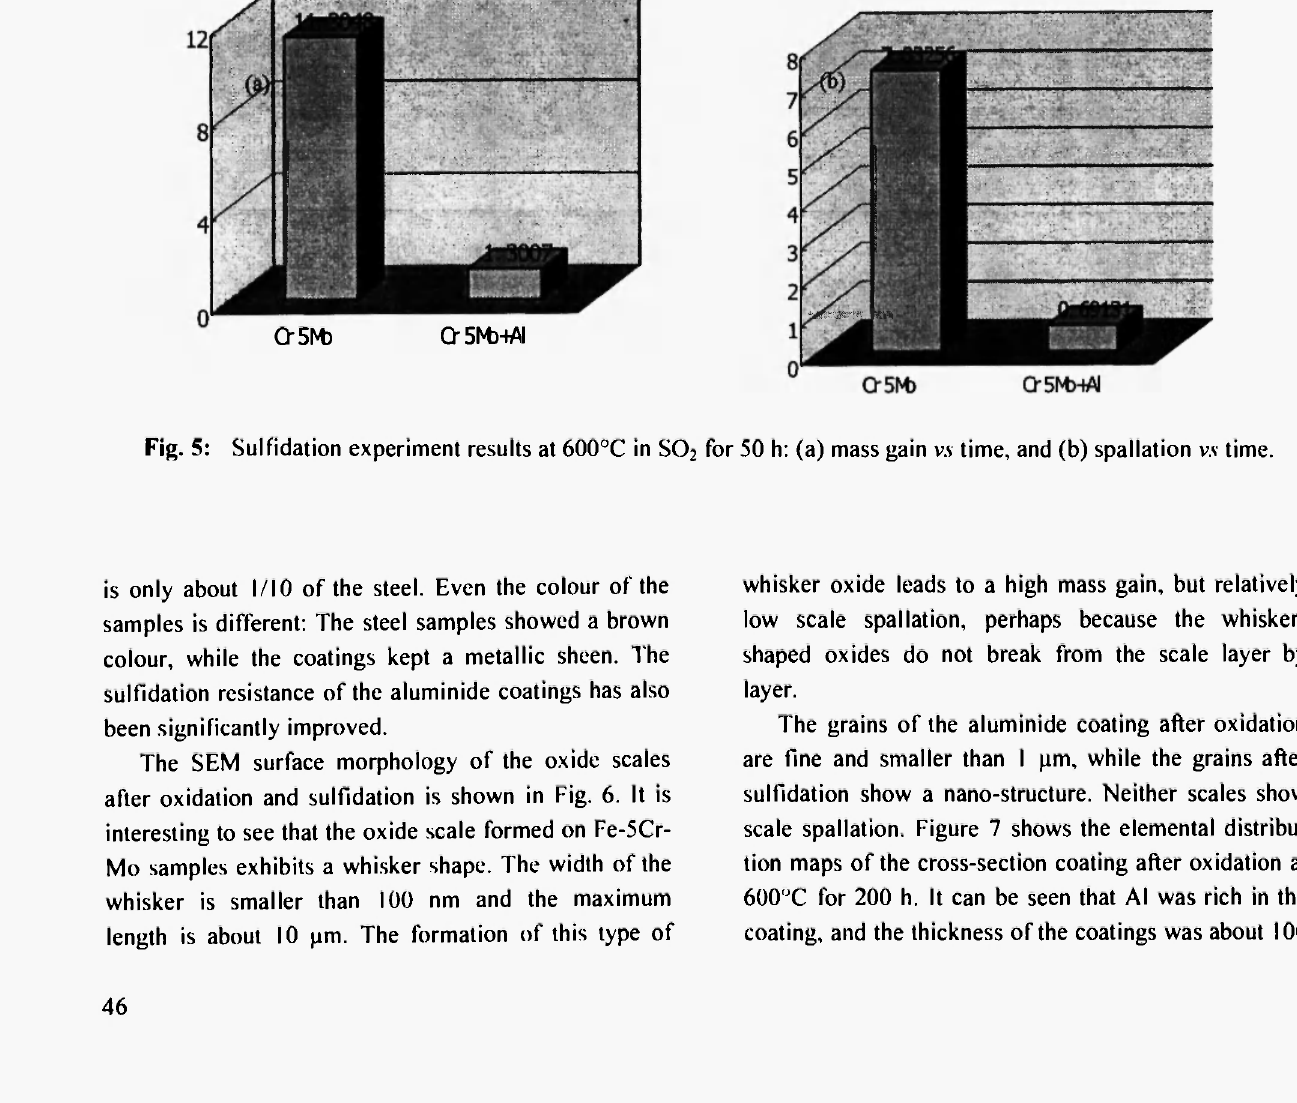
Fig. 5: Sulfidation experiment results at 600°C in S0 2 for 50 h: (a) mass gain v.s time, and (b) spallation v.v time.